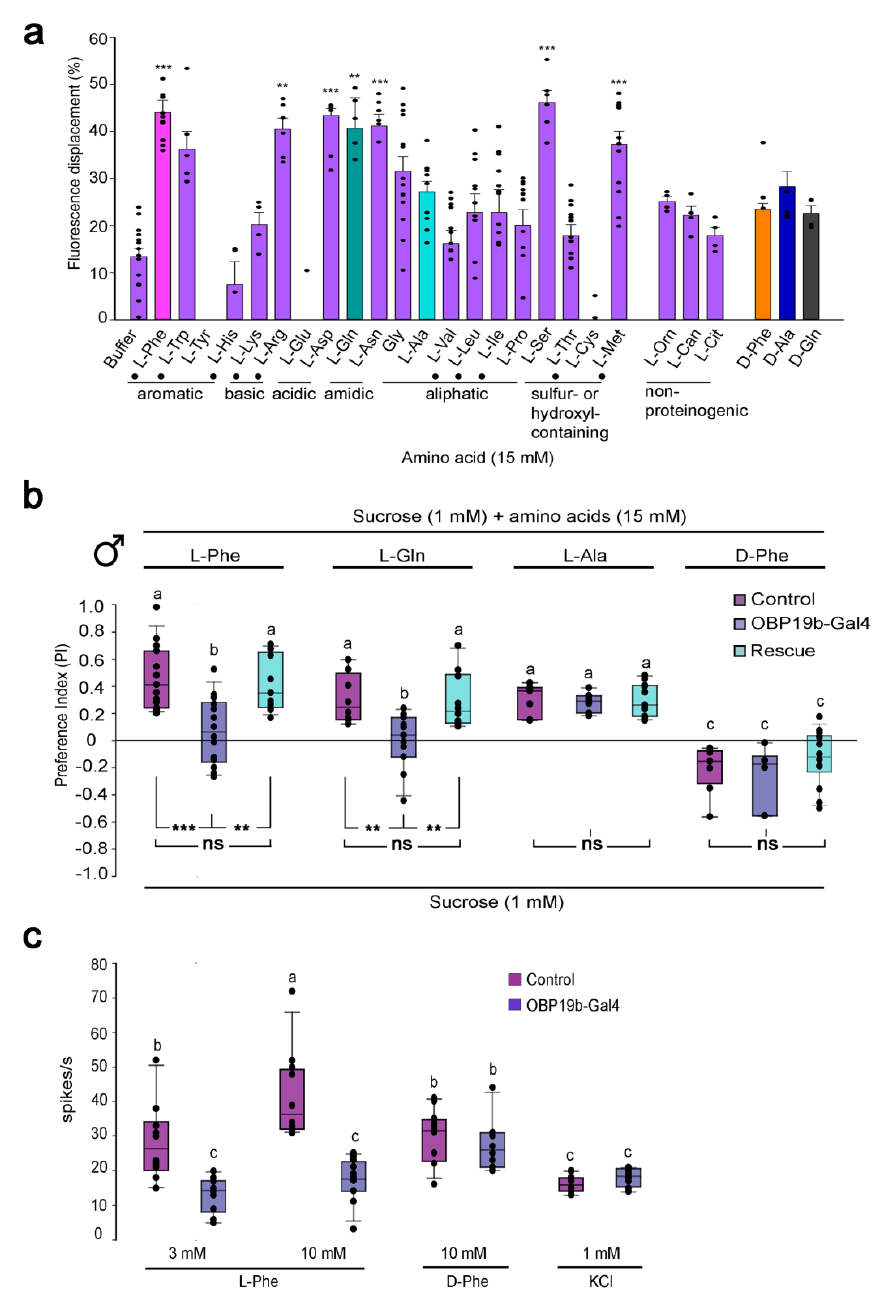
Figure 11. OBP19b is essential for amino acid detection in Drosophila. ( a ) OBP19b displays a high binding affinity for several amino acids. Graph representing the fluorescent displacements of 20 L-amino acids, three non-proteinogenic amino acids (L-ornithine (L-Orn), L- canavanine (L-Can), L-citrulline (L-Cit)) and three D-amino acids (D-phenylalanine (D-Phe), D-glutamine (D-Gln) and D-alanine (D-Ala). The AAs tested are shown in colored bars: three L-amino acids (L-phenylalanine, L-Phe: magenta color, L-glutamine, L-Gln: green and L-alanine, L-Ala: cyan) and three D-amino acids (D-Phe: orange, D-Gln: blue, and D-Ala: grey). The dots indicate essential amino acids. *** p < 0.001; ** p < 0.01; one-way ANOVA followed by Dunnett’s test. ( b ) OBP19b deletion affects Drosophila amino acid taste preference. Preference indices of control, OBP19b-Gal4 null mutant and genetically rescued male flies (OBP19b-Gal4: UAS-OBP19b) for two OBP19b ligands (L-Phe and L-Gln) and two non-ligands (L-Ala and D-Phe). The letters indicate significant differences determined by the Kruskal–Wallis test and a post hoc Wilcoxon test: ns: non-significant, ** p < 0.01; and *** p < 0.001. ( c ) OBP19b deletion alters the single proboscis sensilla electrophysiological responses of Drosophila. Mean ± SEM for the number of spikes/s obtained in control and mutant flies stimulated by 3 and 10 mM L-Phe, 10 mM D-Phe and 1 mM KCl. a/b or b/c: p < 0.01; a/c: p < 0.001, ANOVA and Tukey’s post hoc test. Adapted from